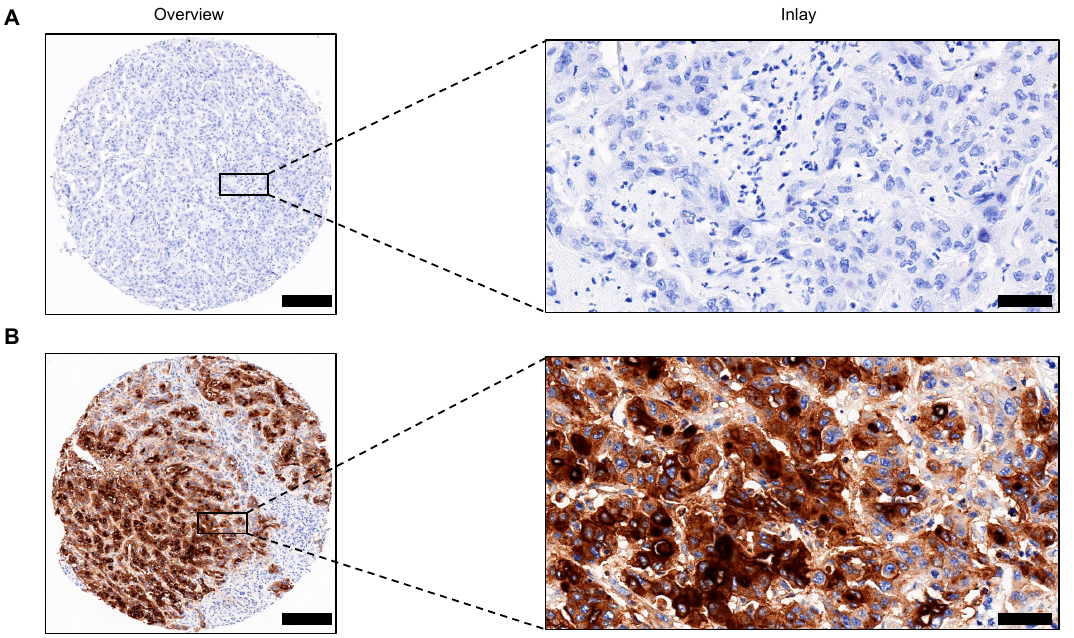
Figure 1. Representative images of MUC16 expression in CCA. ( A , B ) Representative immunohisto- chemistry of the absence ( A ) and presence ( B ) of MUC16 expression in TMA cores of CCA patients. Original magnification ×8.5 for overview and ×40 for inlay, respectively. Scale bars: 200 µm for over- view and 50 µm for inlay, respectively. Abbreviations: Tissue Microarray (TMA).